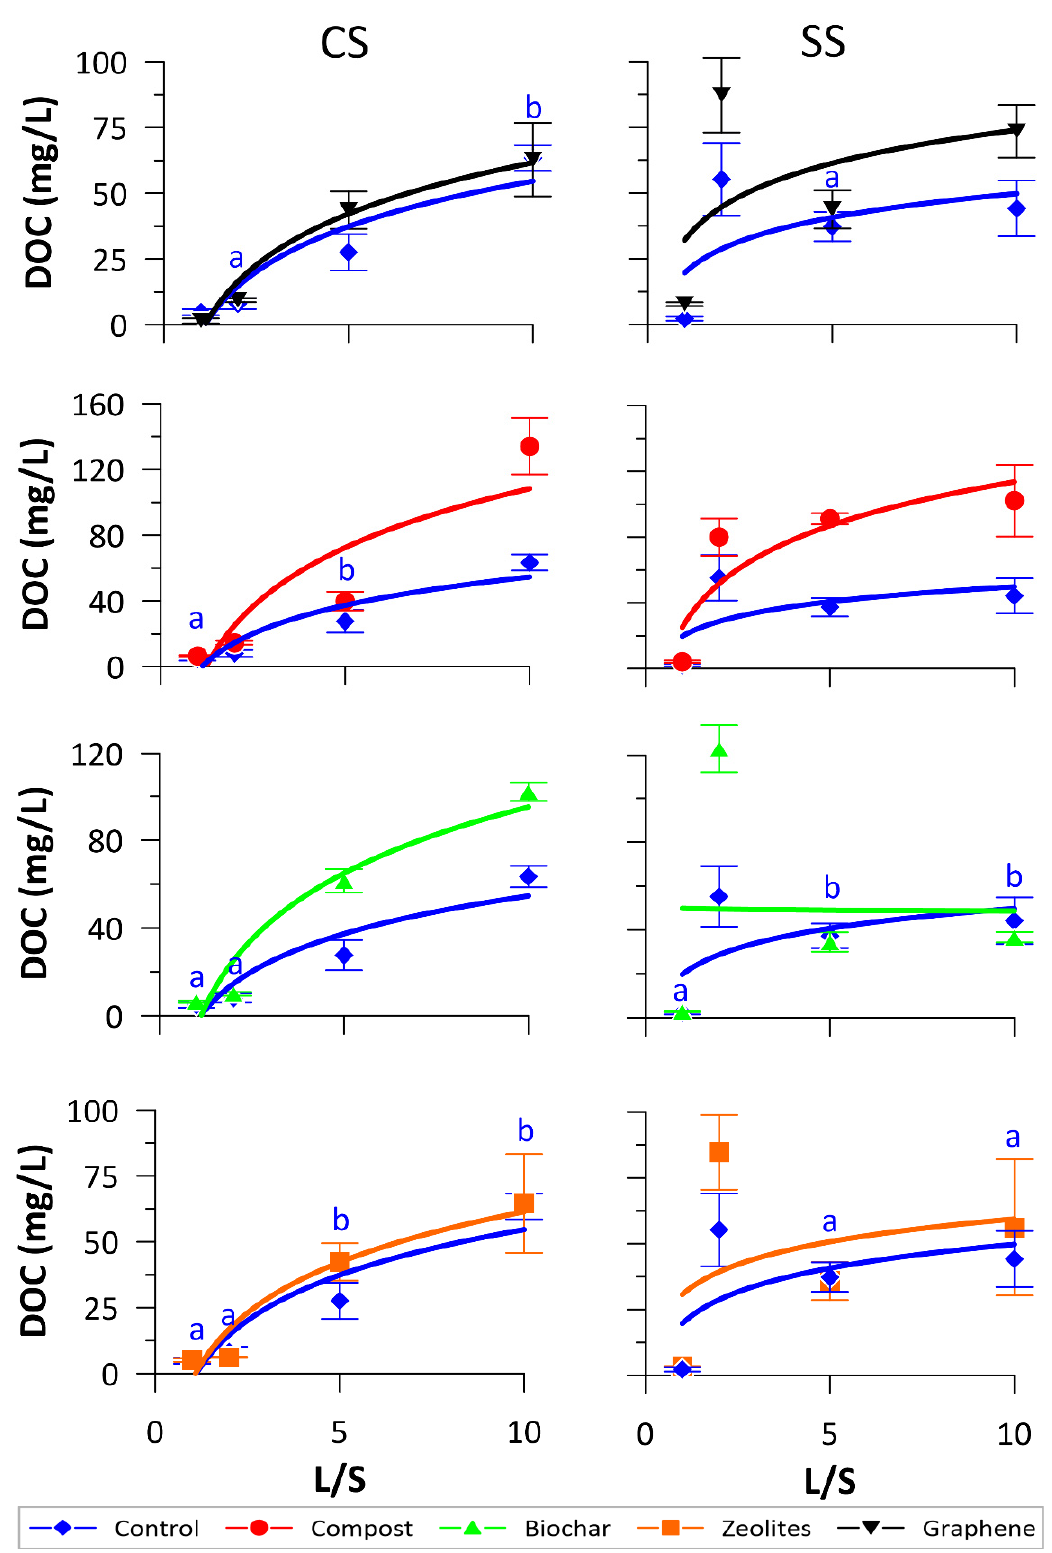
Figure 8. DOC concentration in SSE batches CS ( left panels ) and SS ( right panels ) soils versus L/S ratios values at the end of the monitoring period. Error bars denote standard deviations calculated on three replicates, while lines are best fit natural logarithmic curves. Different letters indicate statistically different means at 0.05 confidence.